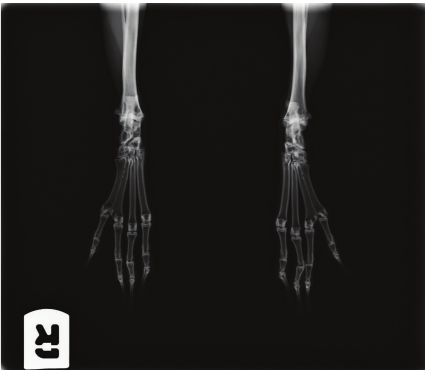
Figure 1: Dorsoplantar view of bilateral syndactyly in a pet rabbit.